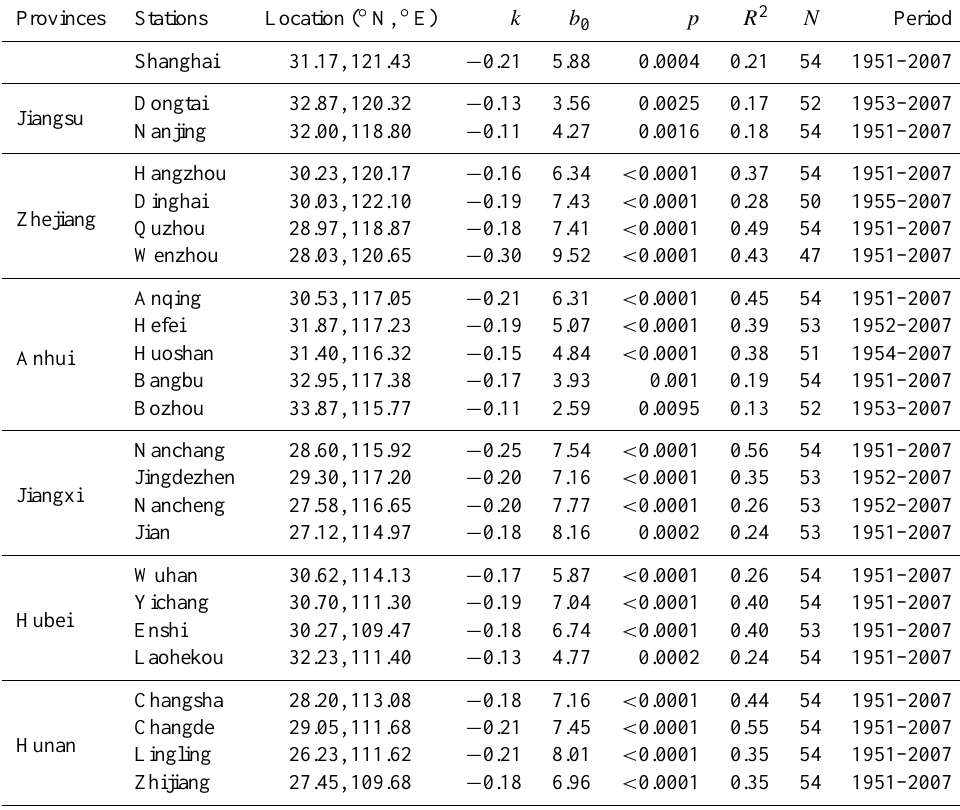
Table 2. Linear regression relationship between winter temperature changes and snowfall days for 24 stations from 1951 to 2007. Provinces Stations